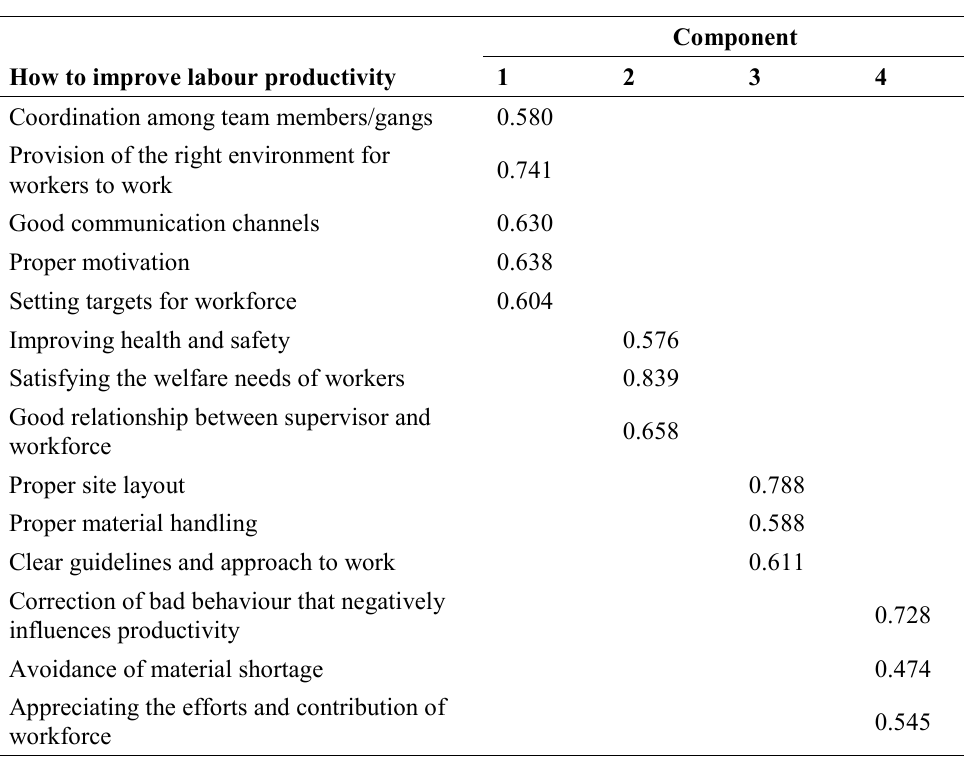
Table 7. Ways of Improving Productivity